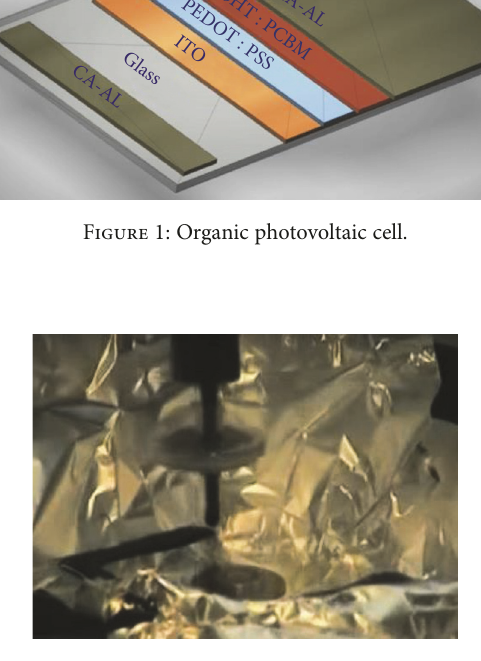
Figure 2: 40 nm PDOT :PSS coating (1 min spin coating at 3000rpm).